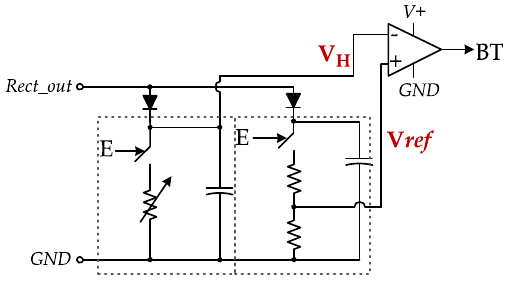
Figure 3. CWAD circuit consisting mostly of passive components [10].